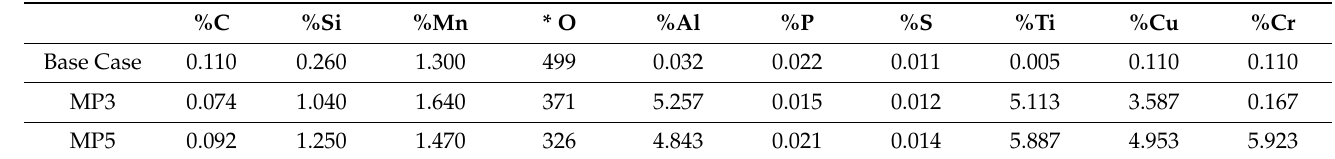
Table 3. Weld metal compositions